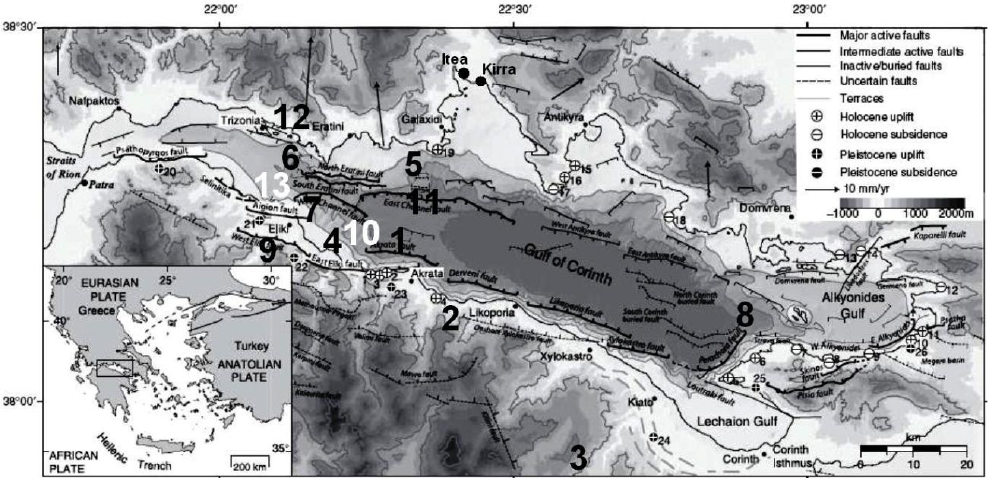
Fig. 1. Map of the Corinth Rift showing topography, bathymetry and faults (after Bell et al., 2009 and references therein). Inset box shows